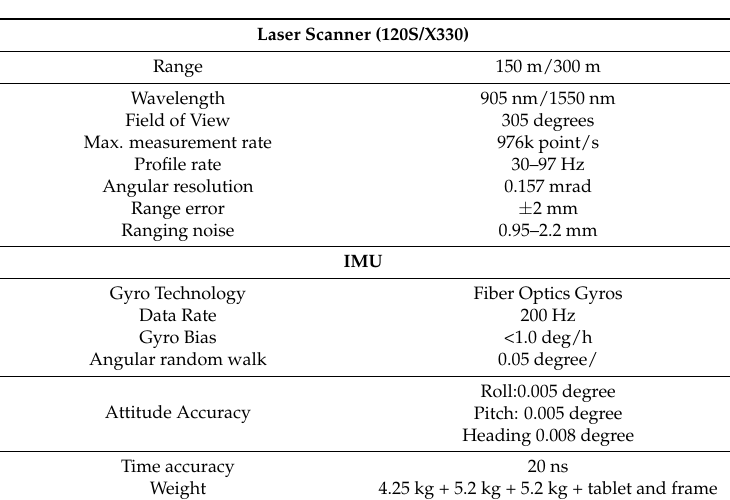
Table 1. Technical specification of SLAMMER.